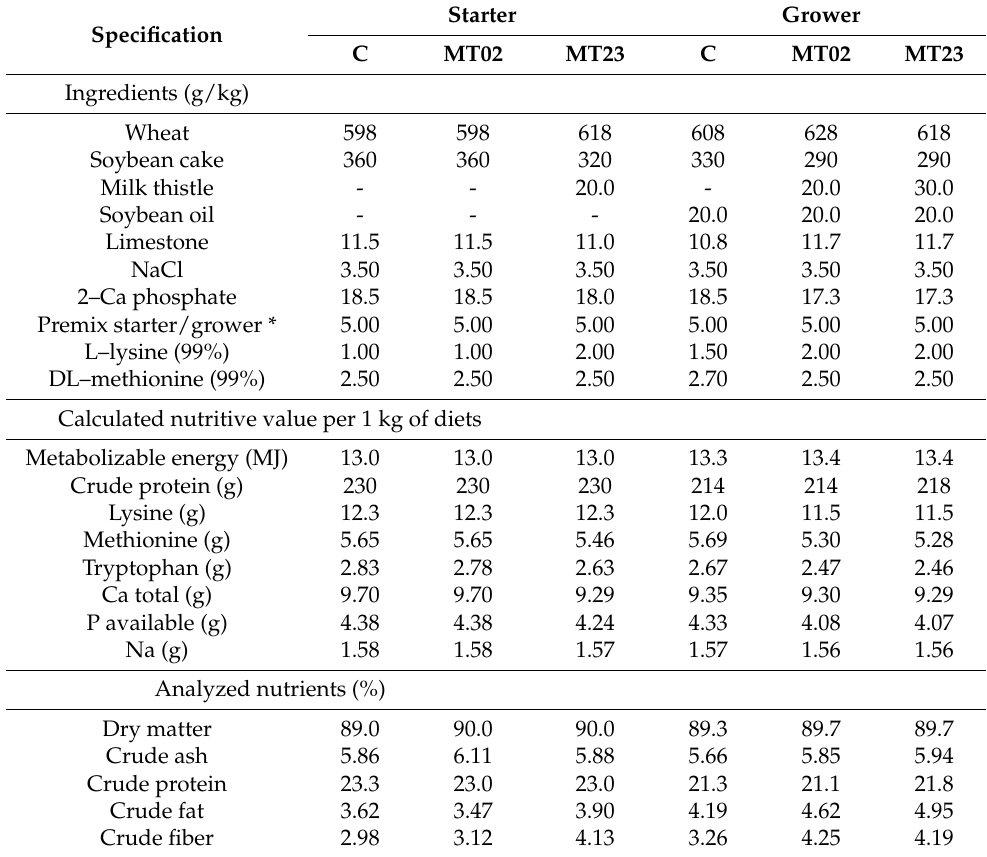
Table 1. Composition and nutritive value of